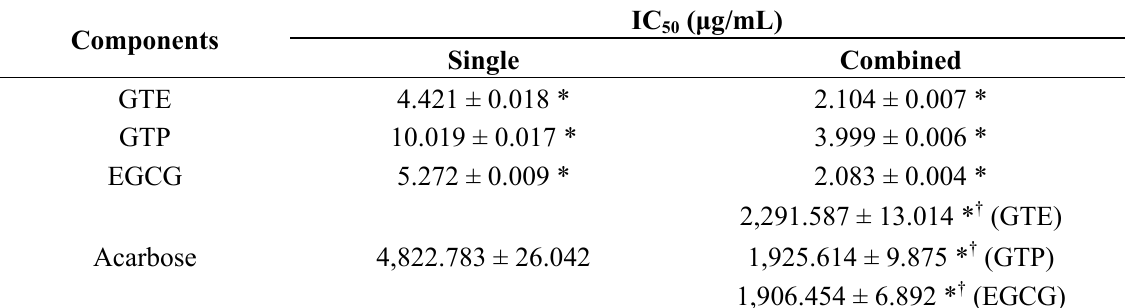
Table 1. The IC values of GTE, GTP, EGCG alone and their combination with acarbose 50 on inhibiting α -glucosidase activity.